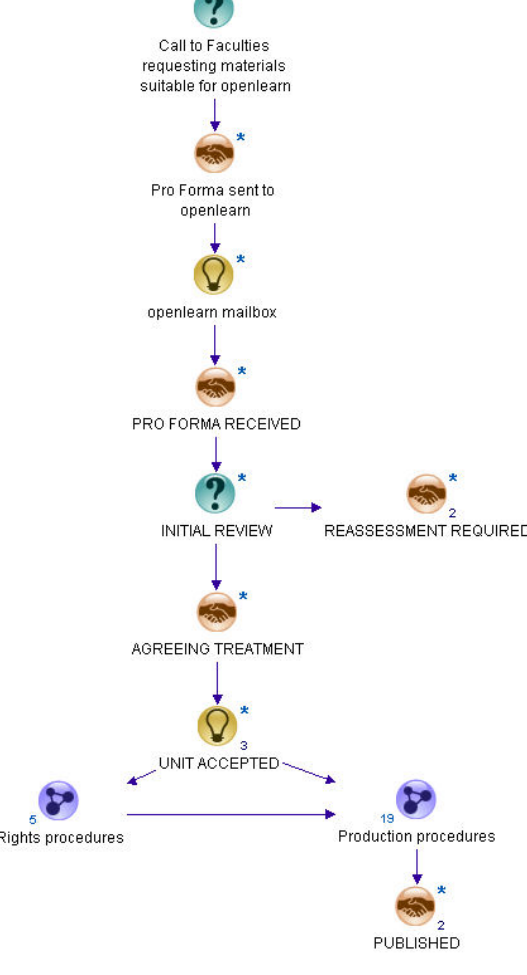
Figure 6 . Compendium map of OpenLearn production